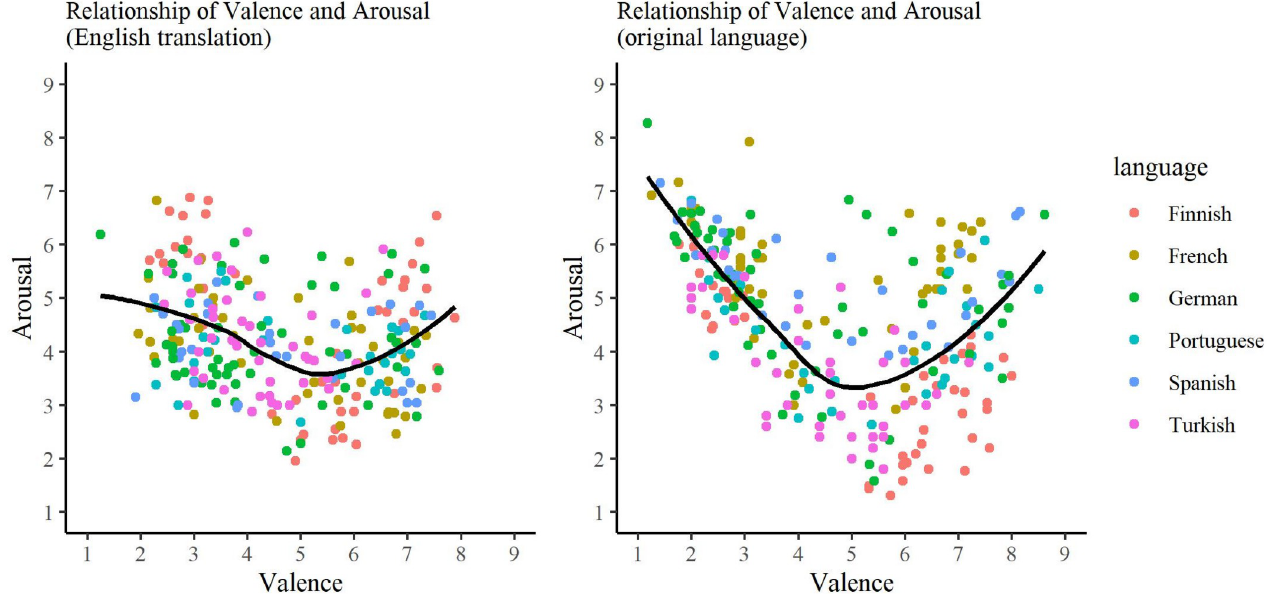
Fig 2. A scatterplot of the relationship between valence and arousal ratings for the English translations (left panel) and original texts (right panel). The different colors correspond to the six languages of the original texts.